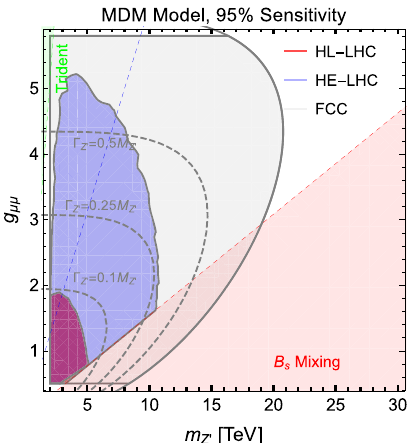
regions are excluded by B s mixing and neutrino trident measurements, respectively. The blue dashed line is for the B s mixing constraint of Ref. [374]. For comparison, the light blue and red regions show the reach of the HE-LHC and HL-LHC,